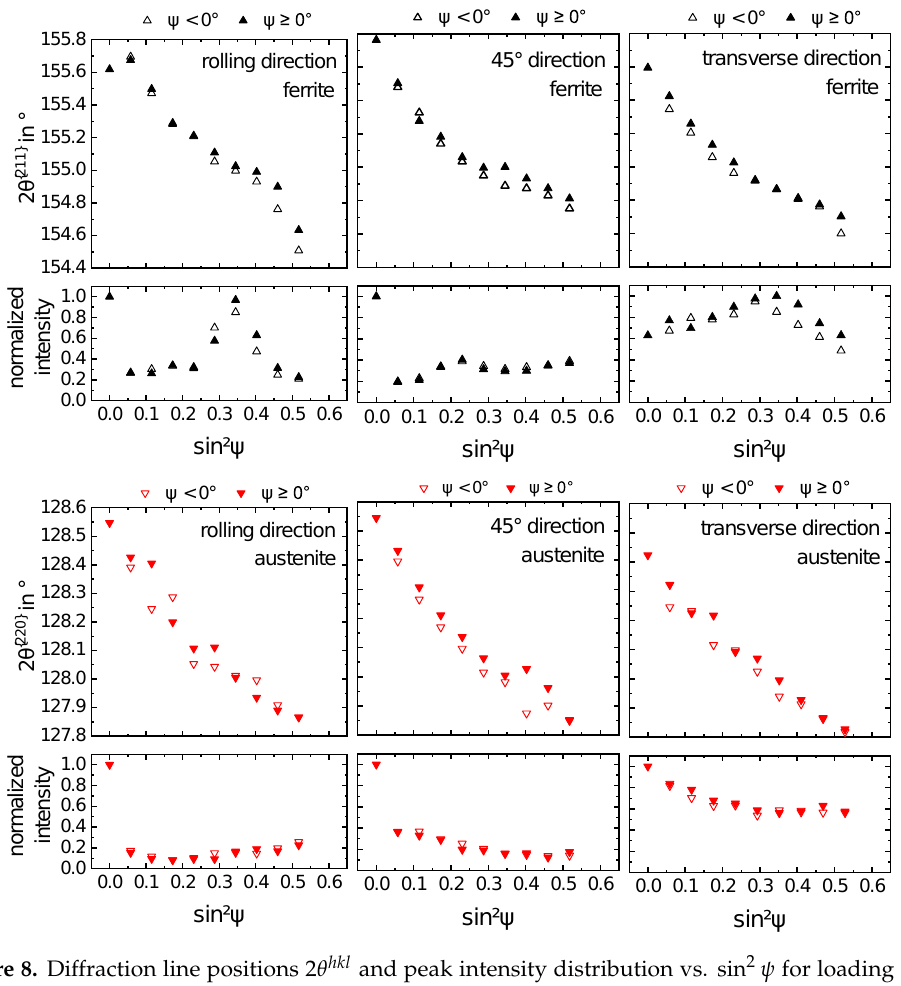
Figure 8. Diffraction line positions 2 θ hkl and peak intensity distribution vs. sin 2 ψ for loading state of σ n = 600MPa in RD ( left ), 45 ◦ ( center ) and TD ( right ) of the ferrite phase ( top ) and the austenite phase ( bottom ).